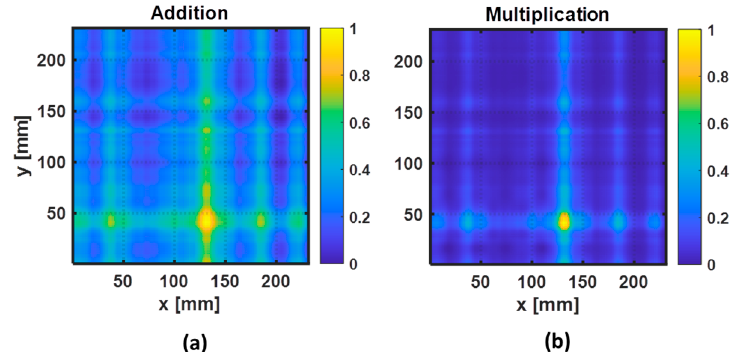
Figure 10. Reconstructed images obtained after the fusion of the three images: ( a ) F 1 +F 2 +F 3 and ( b ) F 1 ·F 2 ·F 3 .